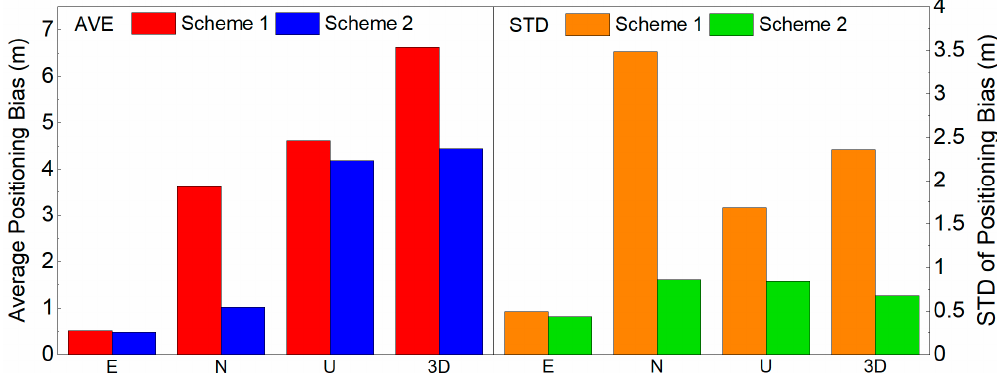
Figure 16. Average value and standard deviation (STD) of positioning biases by using ionosphere-free code observations.